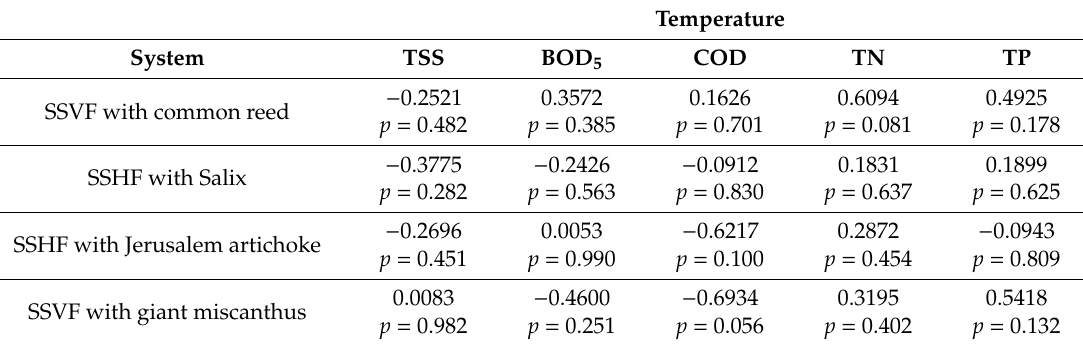
Table 3. Pearson’s correlations and the corresponding p